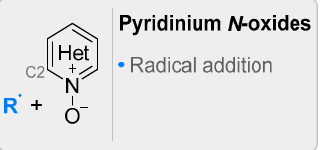
Figure 5. Radical-based transformations of pyridinium N -oxides.